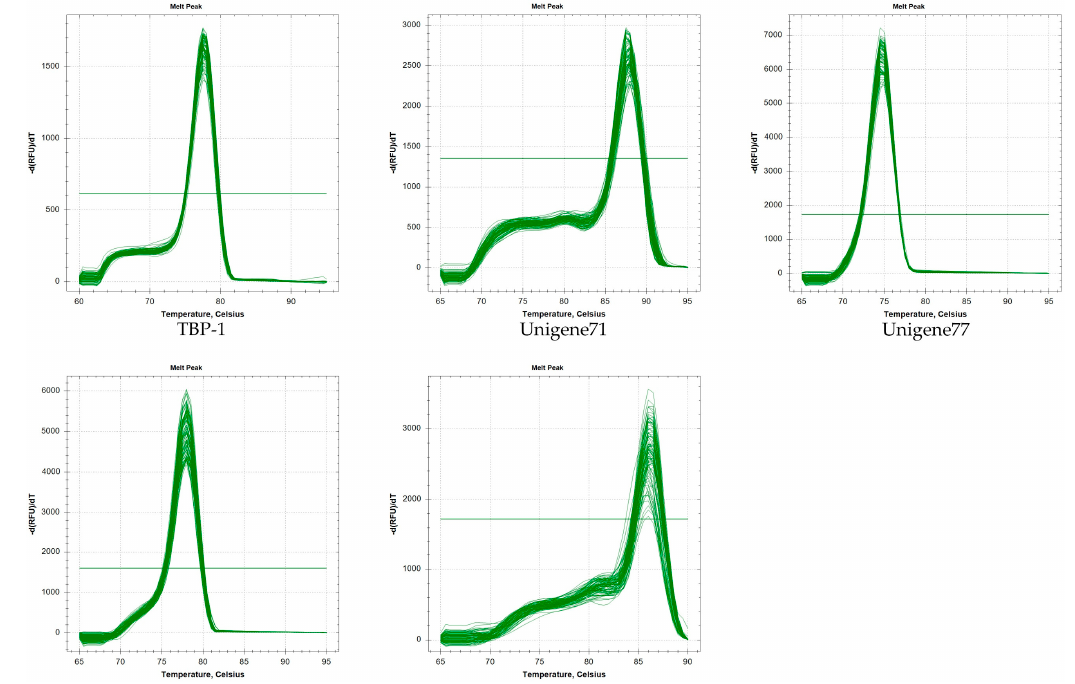
Figure 2. Melting curves for eleven